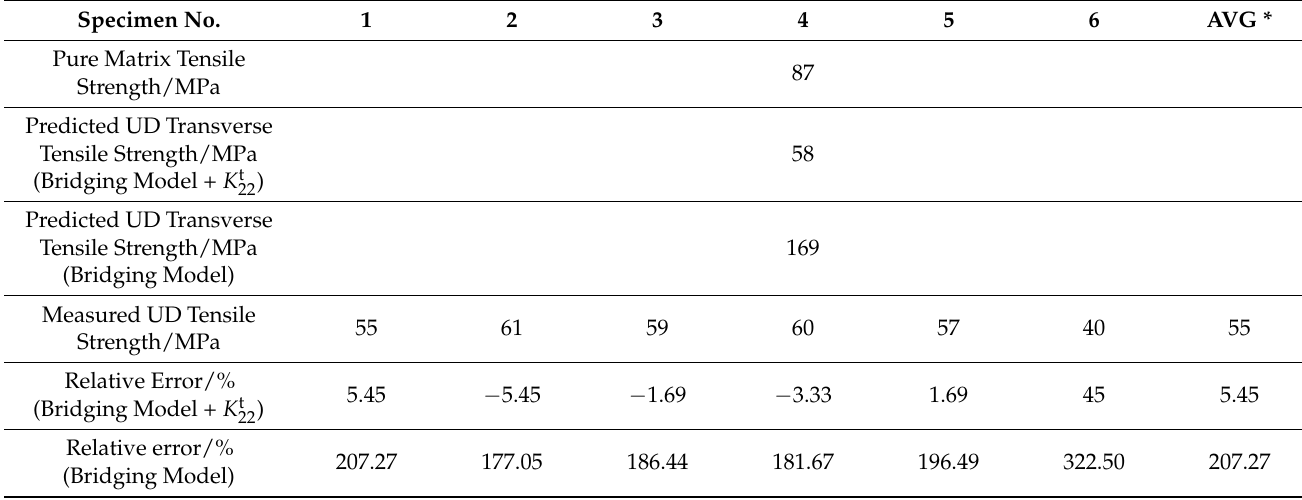
Figure 6. Comparison of predicted results with experimental results. Table 3. Transverse tensile strengths of the six UD composite specimens.